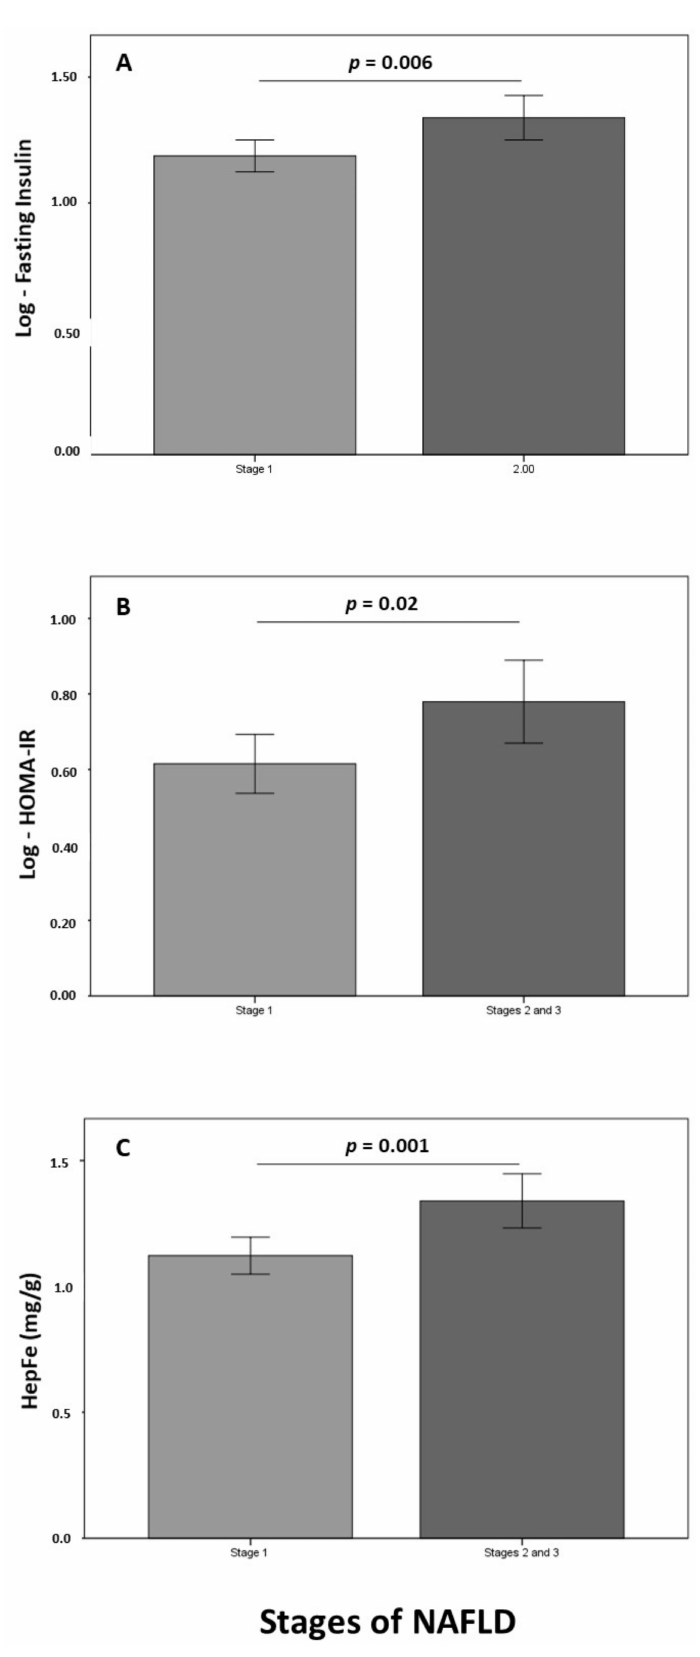
Figure 2. Differences in fasting insulin ( A ), HOMA-IR ( B ), and HepFe ( C ) between stage 1 and stages 2 and 3 of